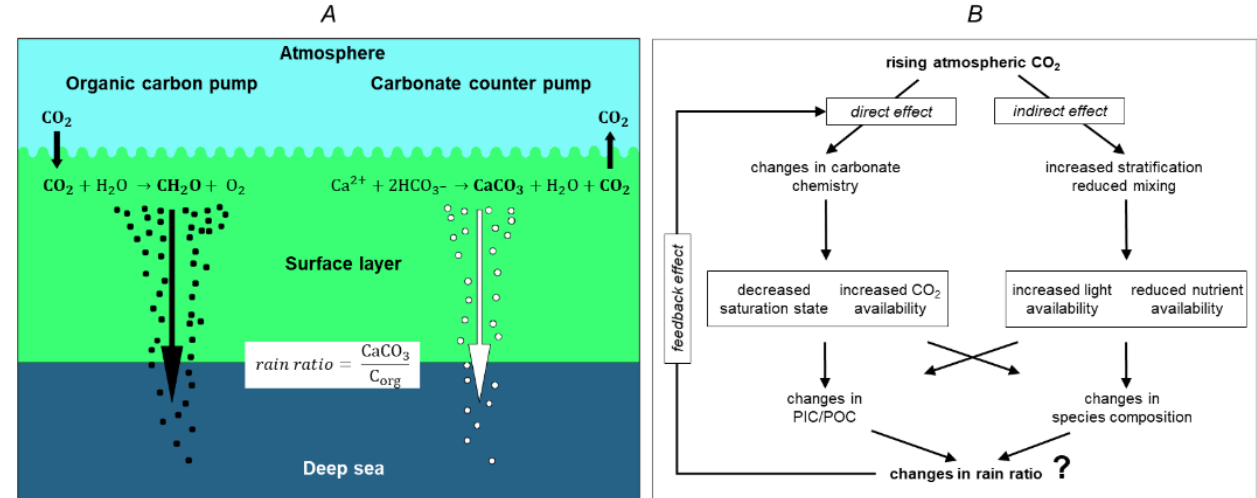
Figure 7. (a) Biological pumps resulting in (i) an atmospheric CO 2 sink and (ii) calcium carbonate transport from surface to deep ocean; (b) anticipated forward and feedback alterations in ocean ecology driven by atmospheric CO 2 increase. PIC: particulate inorganic carbon; POC: particulate organic carbon (modified after Rost and Riebesell,